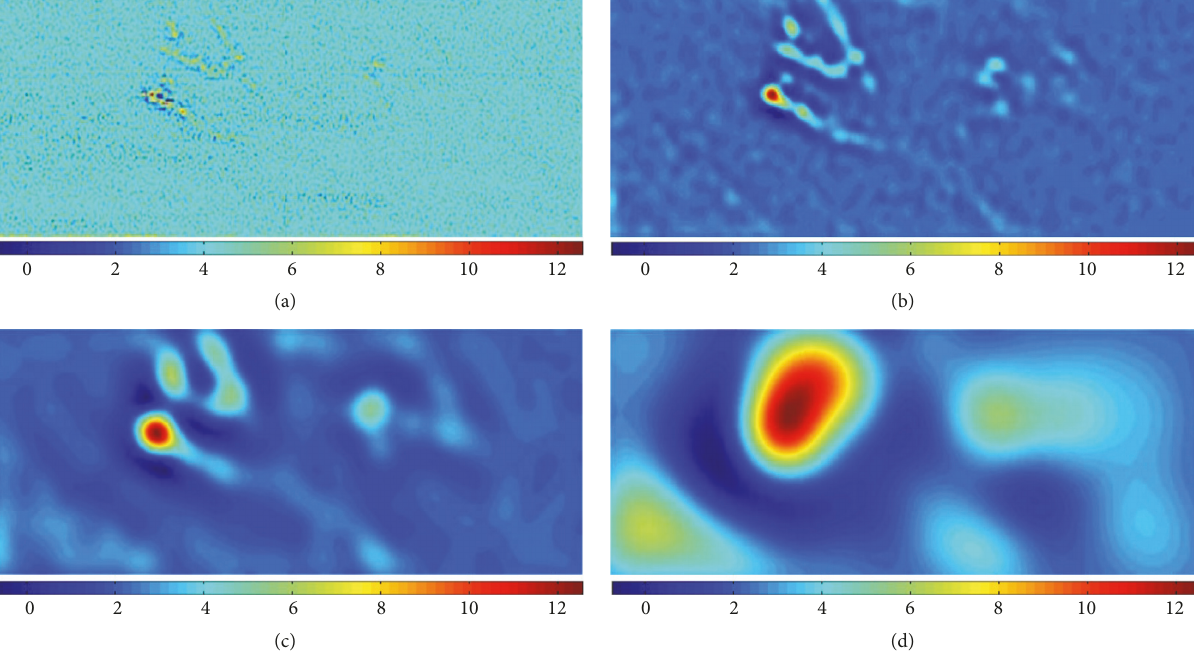
Figure 5: Images at different scales after convolution of the 715th image. Choose the 40th subimage as comparison example. (a) The 1st subimage. (b) The 40th subimage. (c) The 60th subimage. (d) The 80th